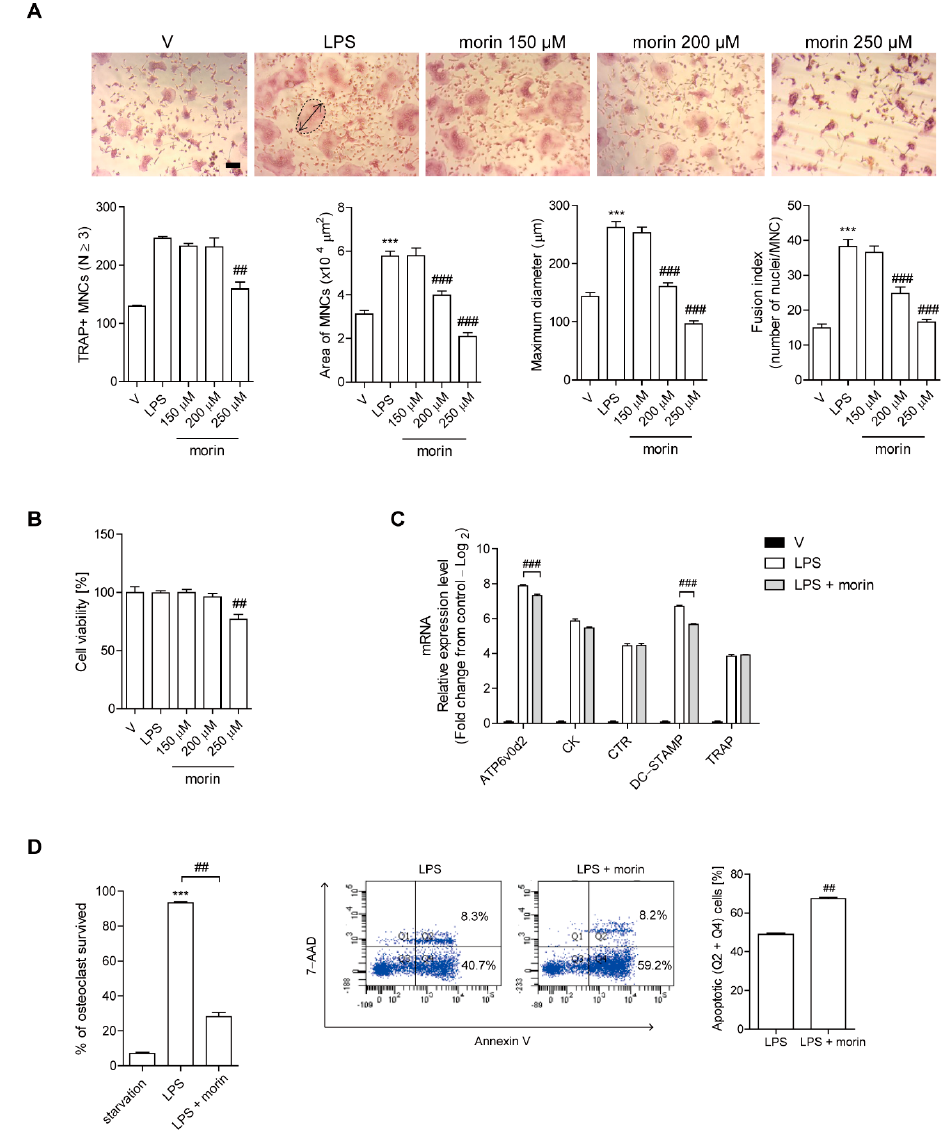
Figure 2. Morin reduces the number of OCs upon LPS stimulation in vitro. BMMs (10 4 cells/well) were cultured with M-CSF (30 ng/mL) and RANKL (40 ng/mL) for 40 h, and then incubated further for 48 h ( A , B ) or 24 h ( C ) with M-CSF (30 ng/mL) and LPS (50 ng/mL) ± morin (150 µ M, 200 µ M, 250 µ M). LPS and morin were dissolved in PBS and methanol, respectively, as a vehicle. ( A ) After fixation and TRAP staining, more than 70 MNCs were selected randomly to evaluate the OC area (dotted line) and the maximum diameter (double arrow). The fusion index is presented as the average number of nuclei per TRAP-positive MNCs formed in the culture. Representative photos are shown. Scale bar: 100 µ m. ( B ) Cell viability was performed by the MTT assay, and no obvious toxicity was found for the range of used morin concentrations compared with vehicle-treated cells. ( C ) The mRNA expression of OC-specific genes in LPS-stimulated cells in the presence or absence of morin (200 µ M) was analyzed by qPCR. Gene expression was visualized as the mean fold change of mRNA levels relative to RANKL pre-treatment samples (log 2 scale). ( D ) Mature OCs were stimulated with LPS (50 ng/mL) with or without morin (200 µ M) in the presence of M-CSF (30 ng/mL) for 6 h to measure TRAP-positive MNCs and annexin V-positive cells to evaluate OC survival. *** p < 0.001 compared with PBS-treated pre-OCs. ## p < 0.01, ### p < 0.001 compared with LPS-treated cells. Similar results were obtained from three independent